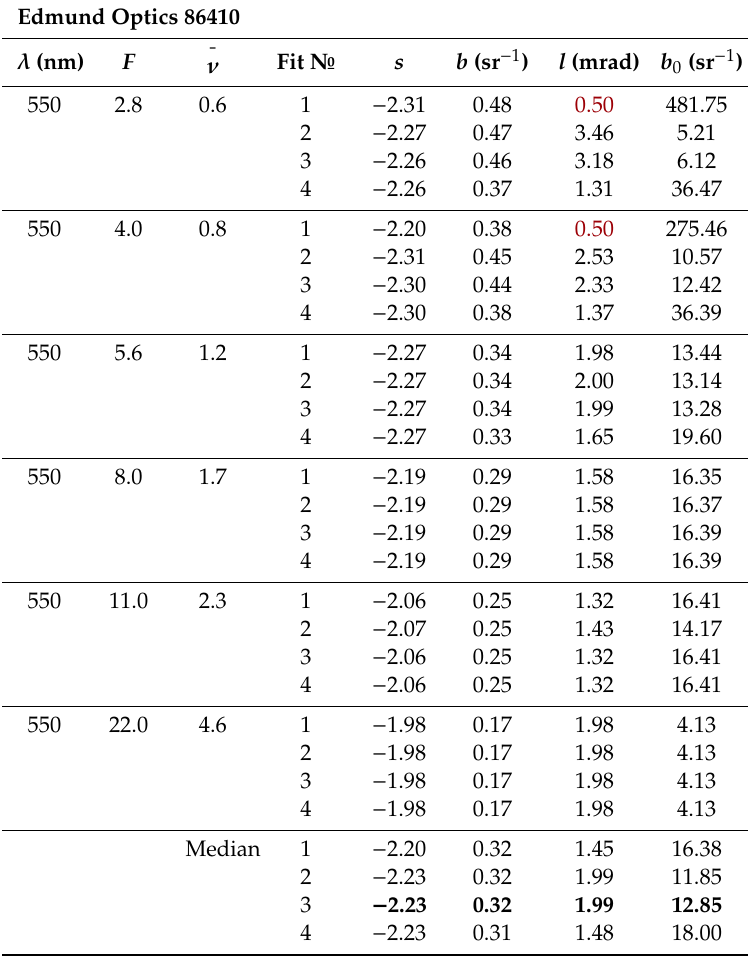
Table A3. Fit results for the lens Edmund Optics